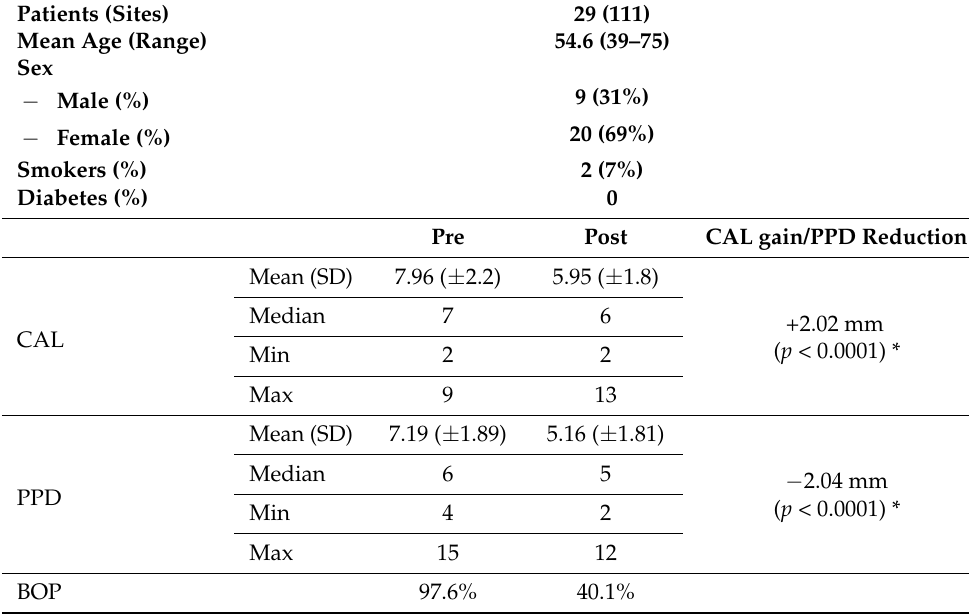
Table 1. Patient demographics and mean clinical parameters before (pre) and after (post = 6 months) the treatment. CAL = clinical attachment level, PPD = probing pocket depth, BOP = bleeding on probing, * = Wilcoxon signed-rank test.